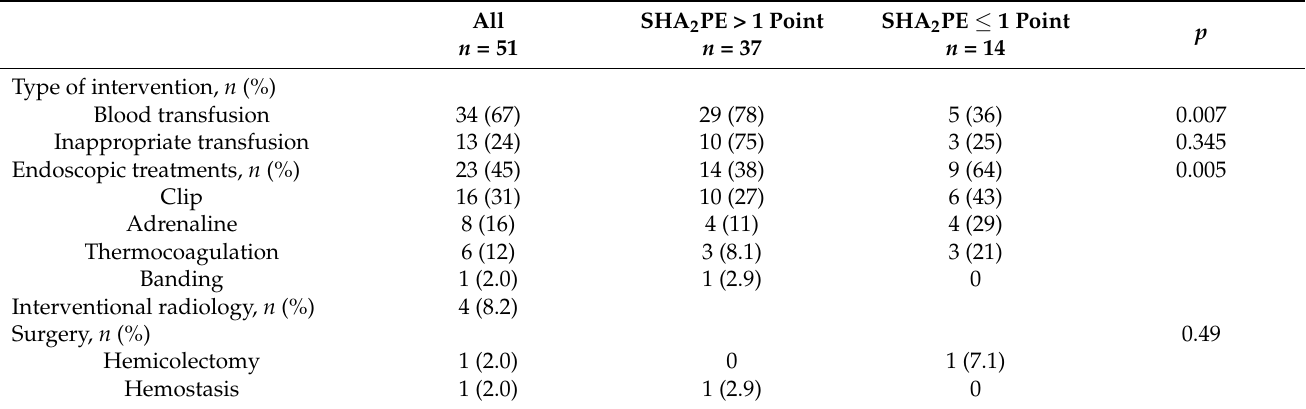
Table 5. Interventions included in the SHA 2 PE